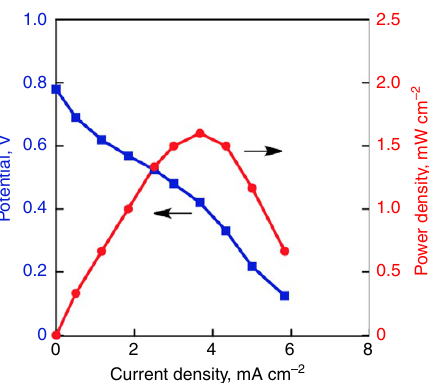
Figure 4 | Generation of electrical energy in the one-compartment H 2 O 2 fuel cell. I – V (blue) and I – P (red) curves of the one-compartment H 2 O 2 fuel cell with a Ni mesh anode and Fe II 3 [Co III (CN) 6 ] 2 /carbon cloth cathode in the reaction solution containing H 2 O 2 (47.9mM) produced by photocatalytic reaction in seawater as shown in Fig. 2 (blue